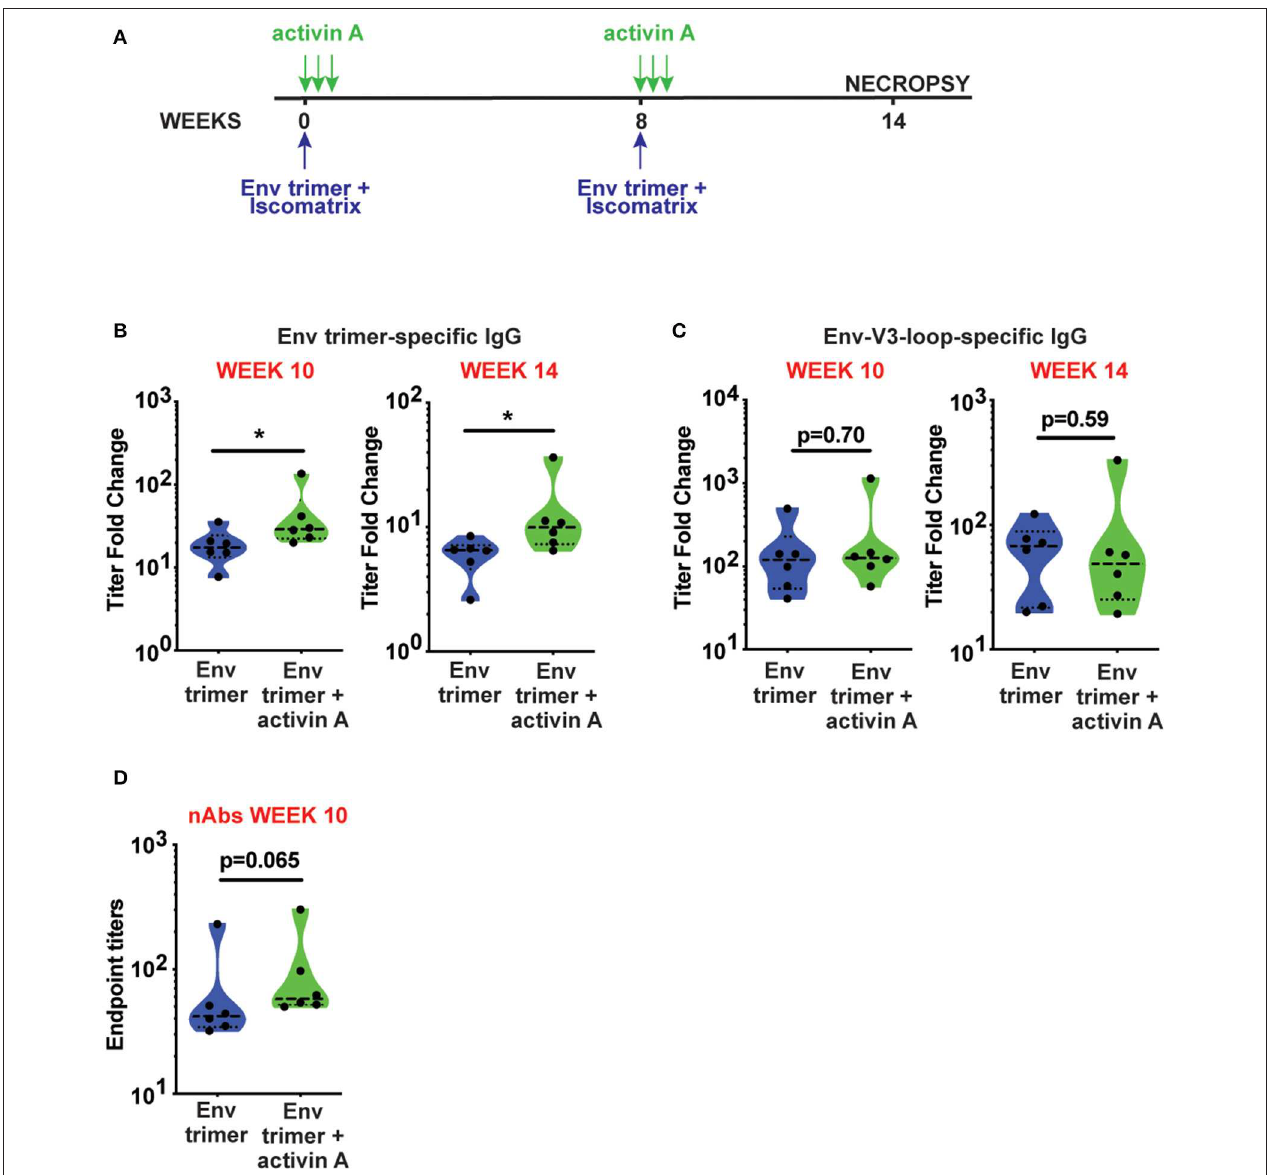
FIGURE 1 | Activin A modulated generation of BG505 SOSIP Env trimer-specific Abs. (A) Timeline of immunizations (blue) and activin A administration (green). (B,C) Env trimer (B) and Env-V3-loop (C) -specific IgG titers at week 10 and week 14 are shown as fold change in titers [ratio between Env-specific ELISA endpoint titers at week 10 or week 14 and the pre-immune titers (week-1)]. (D) Neutralizing Ab (nAb) titers were measured at week 10 post immunization. Limit of detection of the neutralization assay is 1:10. In (B–D) , violin plots show median and quartiles. Each symbol represents an individual animal * p <